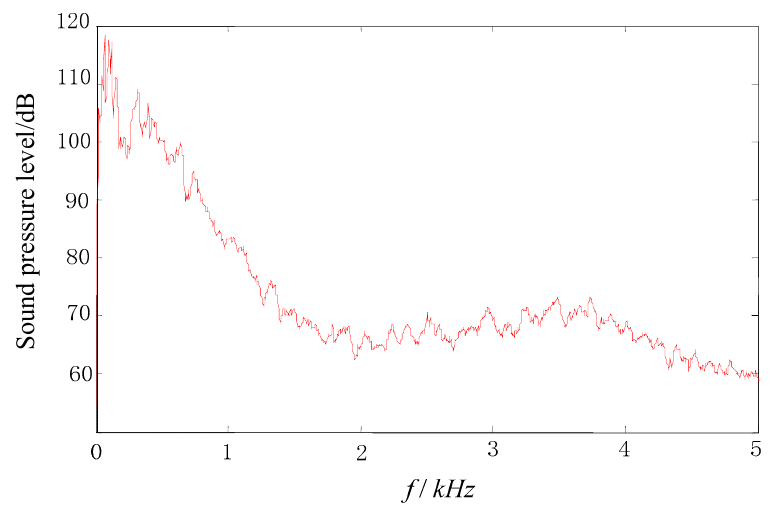
Figure 19. Diagram of sound radiation power from the model in the experiments. The red line denotes the hydrodynamic noise from the model at a velocity of 8.68 m/s. The horizontal axis indicates the frequency range, while the vertical axis indicates the level of sound radiation power.